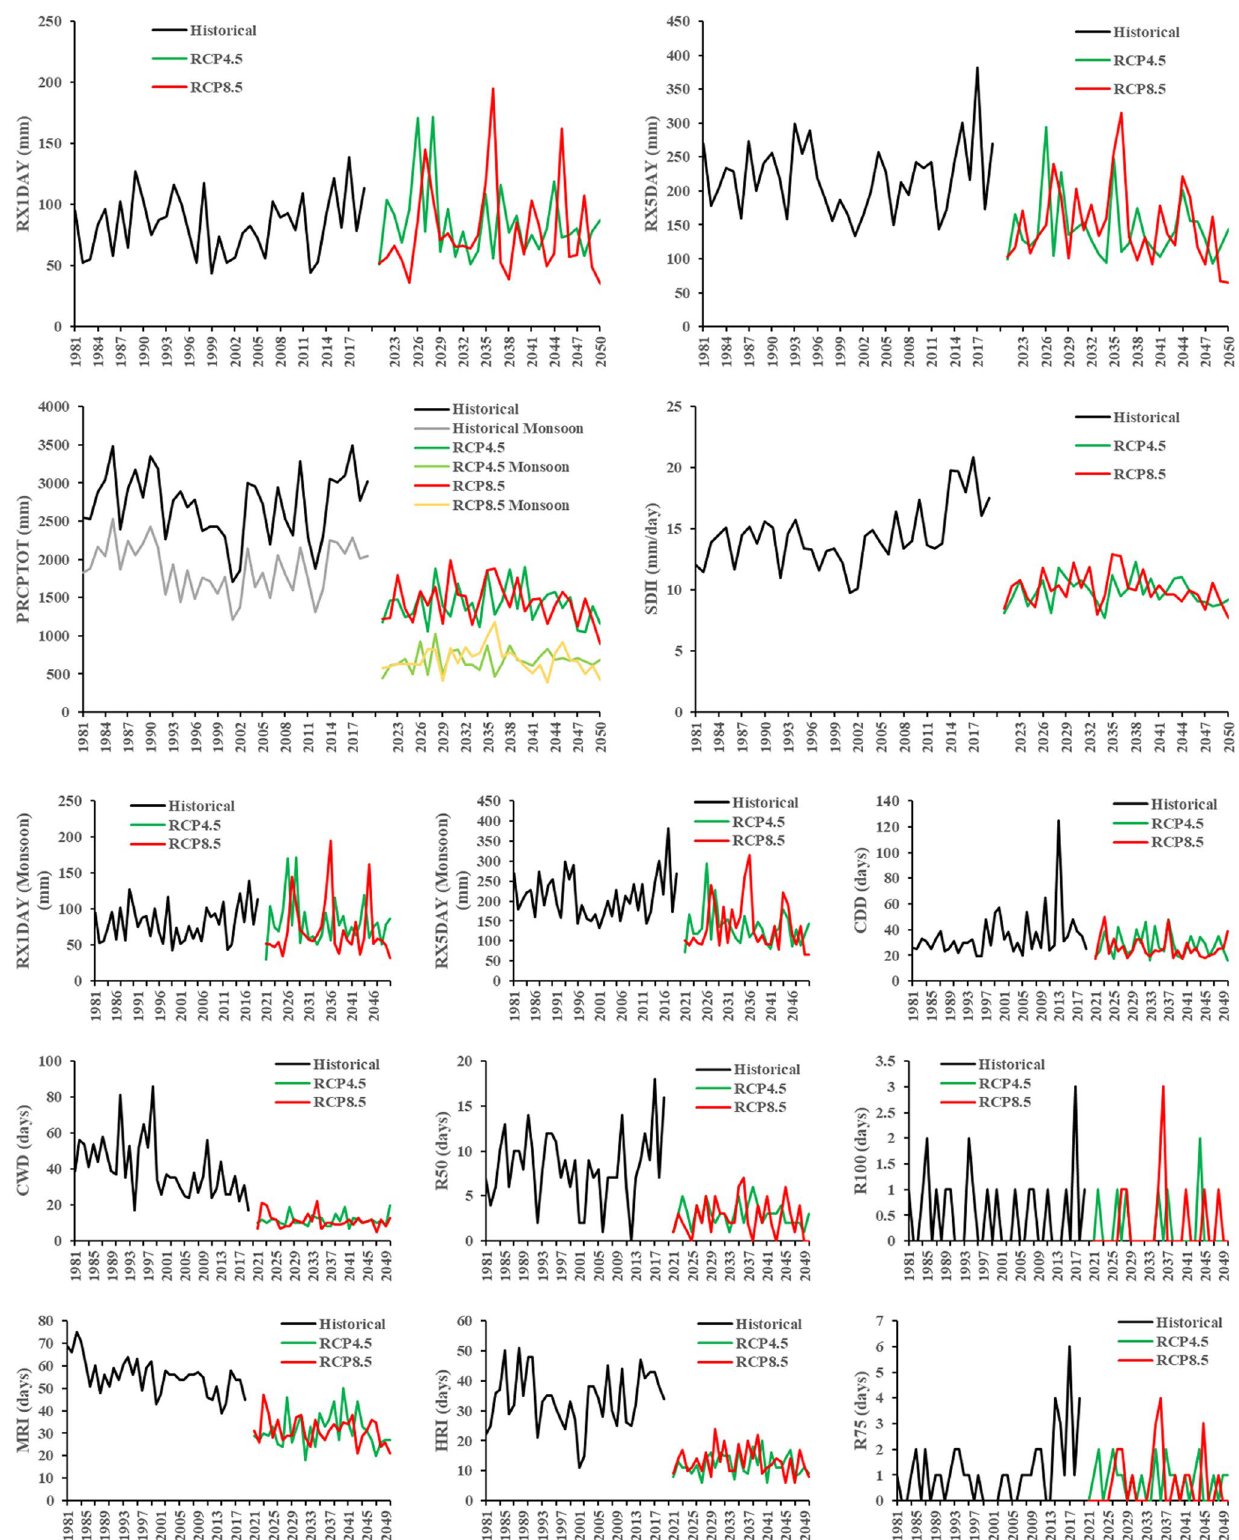
Fig. 5 Precipitation extremes for historical (1981–2019), RCP 4.5 scenario (2021–2050) and RCP 8.5 scenario